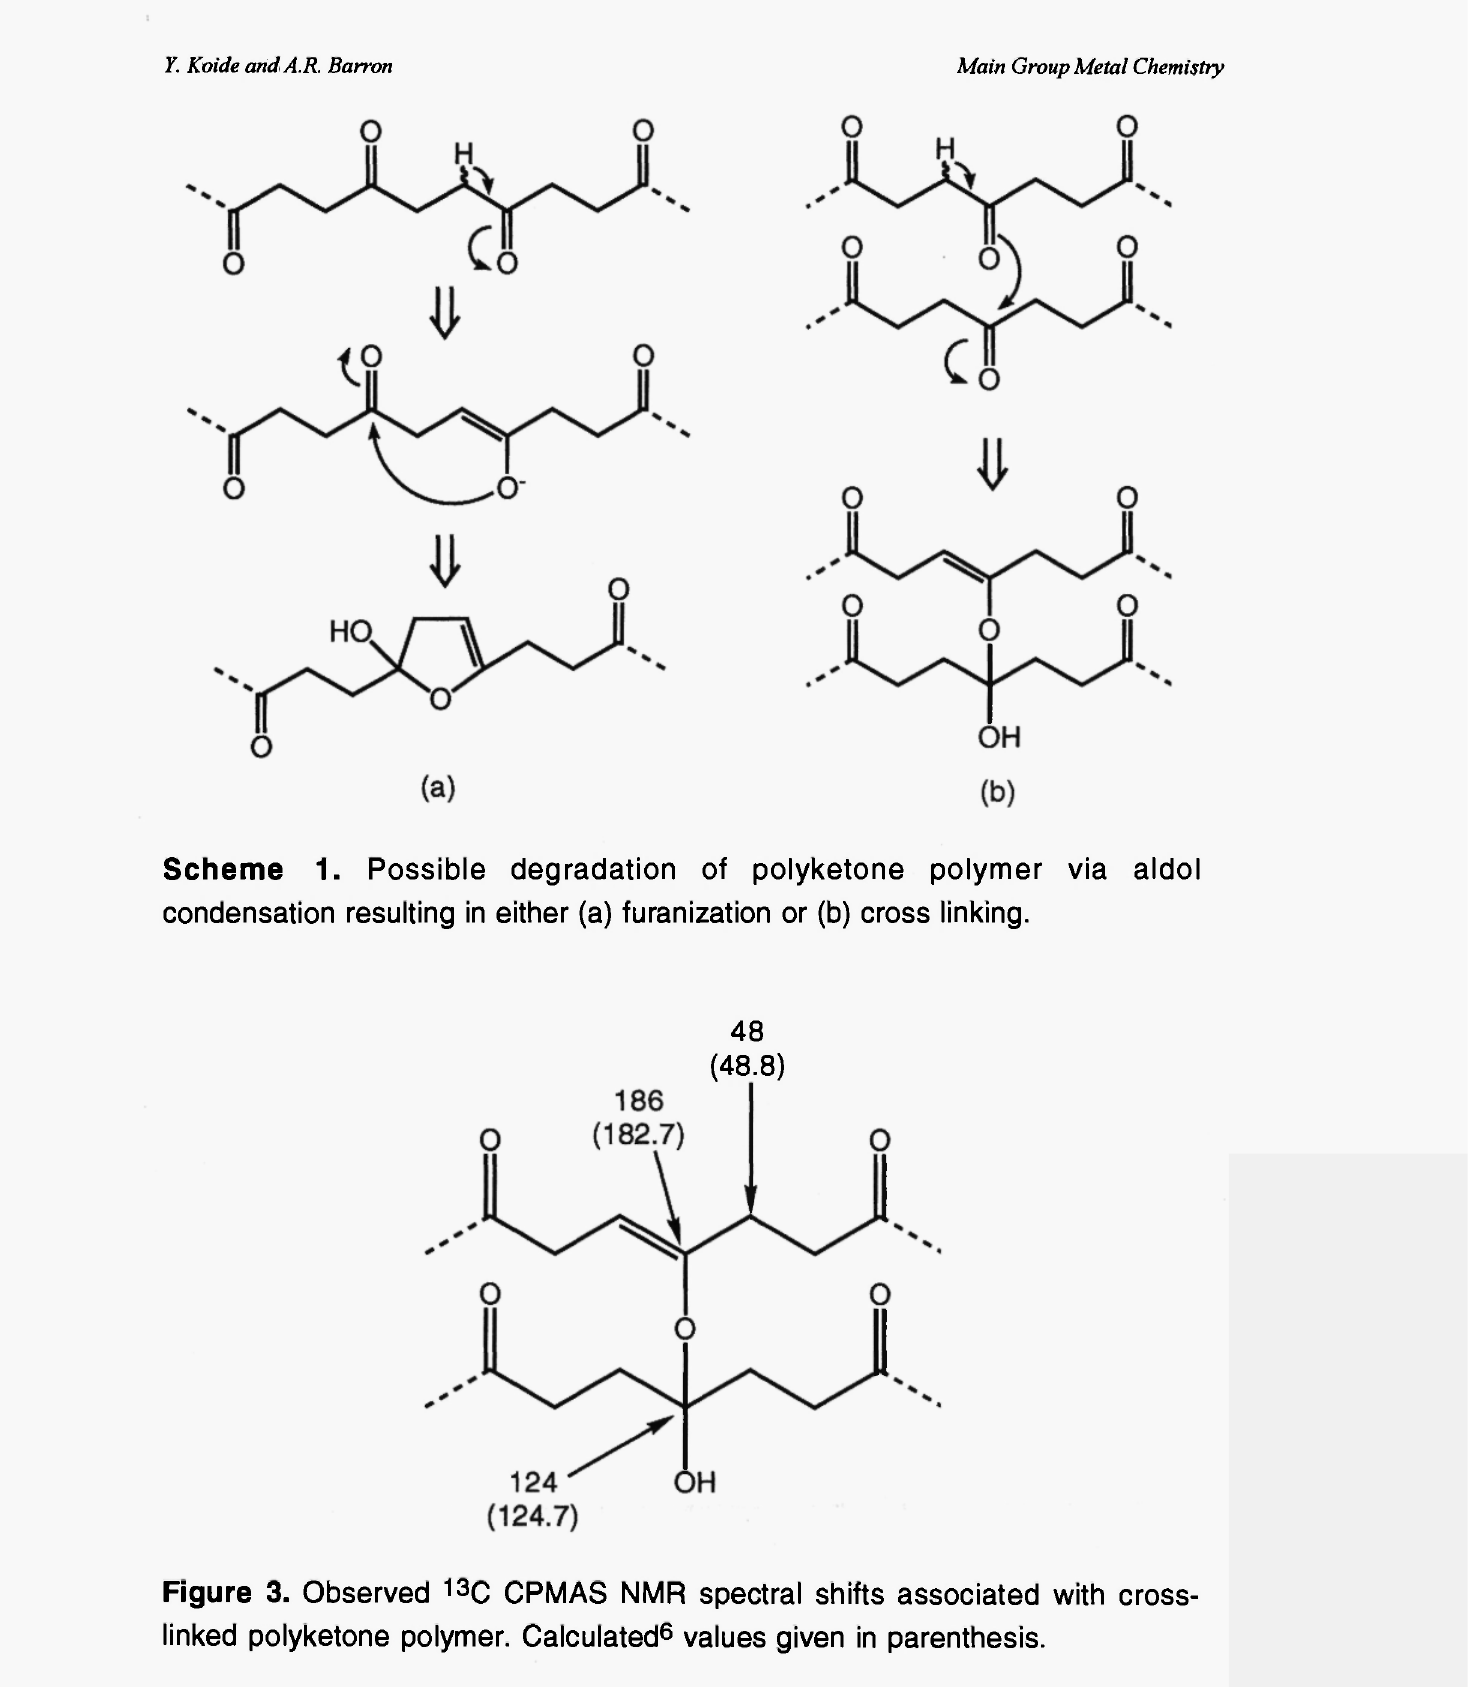
Figure 3. Observed 13 C CPMAS NMR spectral shifts associated with cross- linked polyketone polymer. Calculated 6 values given in